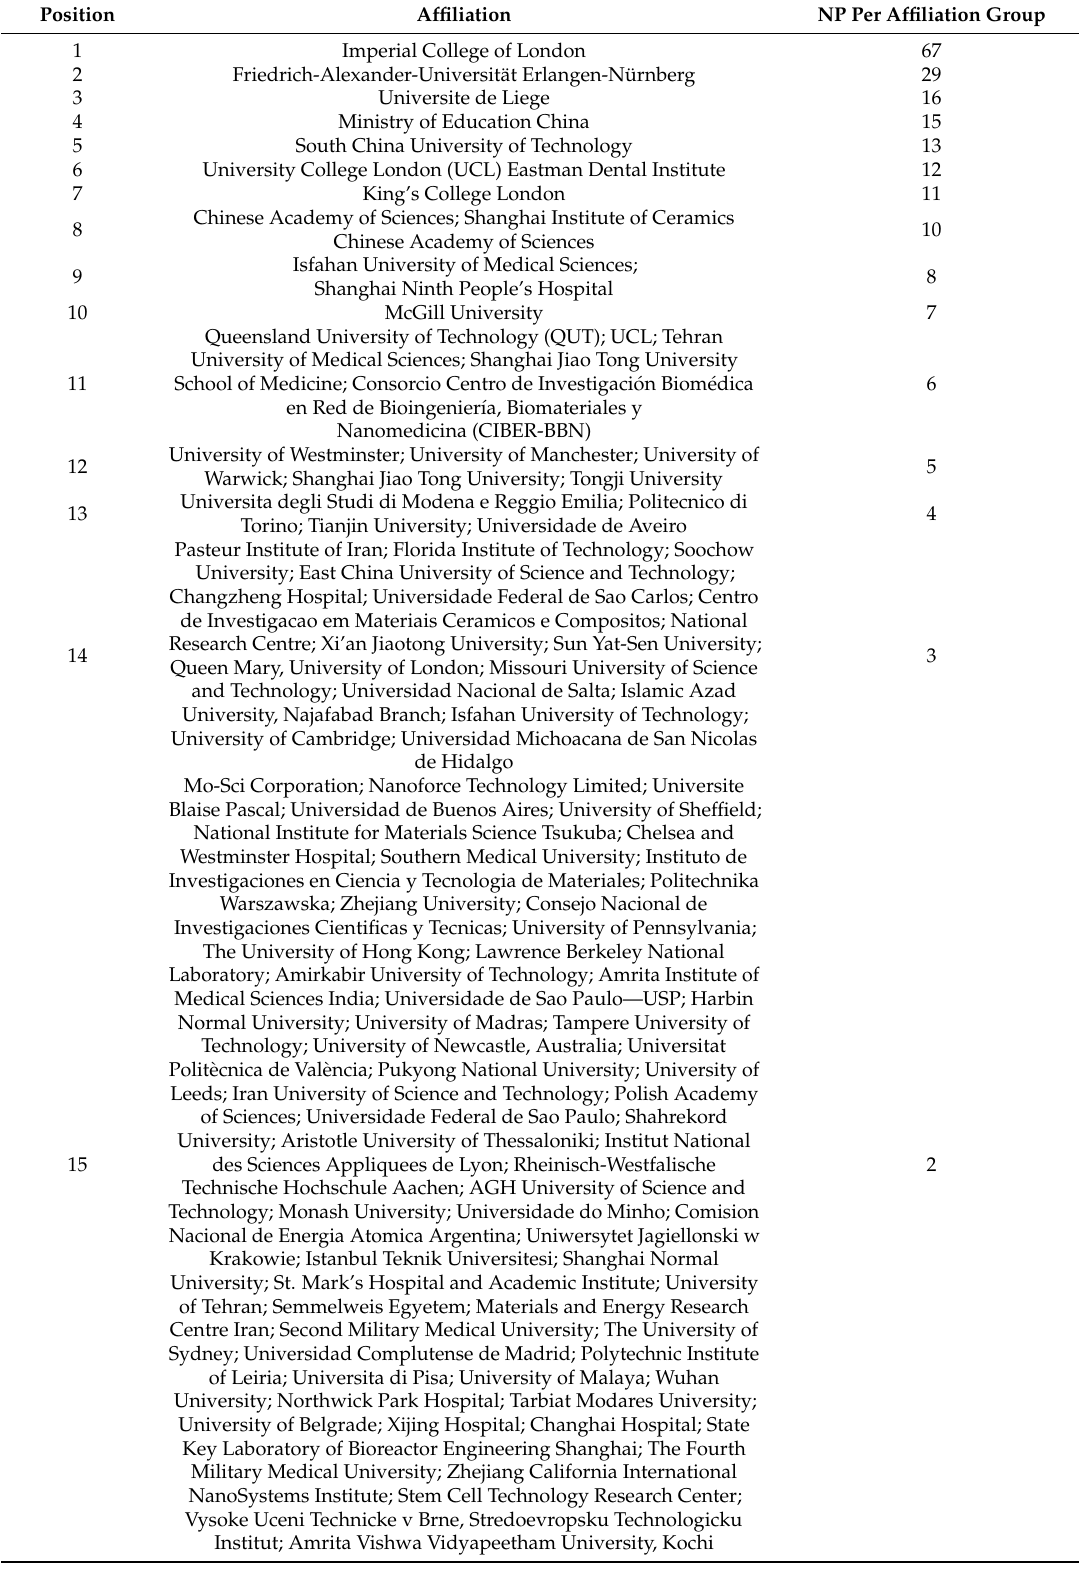
Table 6. Affiliations organised after bucketing by number of